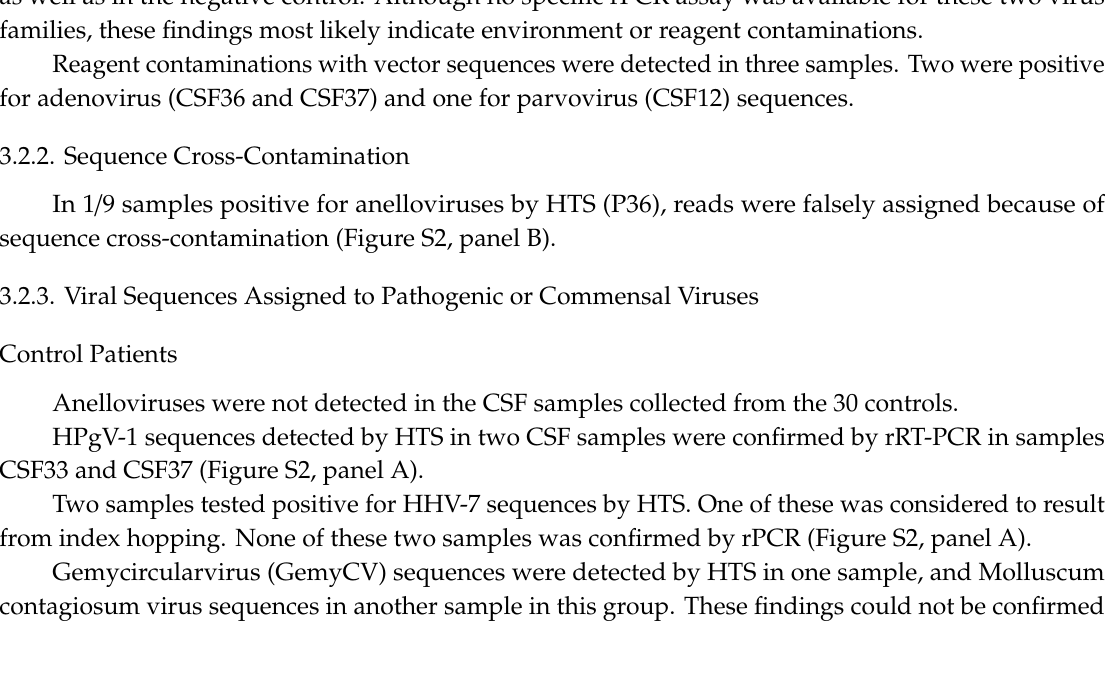
*3 electroencephalogram, *4 within the three months after the first day of hospitalization, *5 white blood cells, *6 Laboratory reference